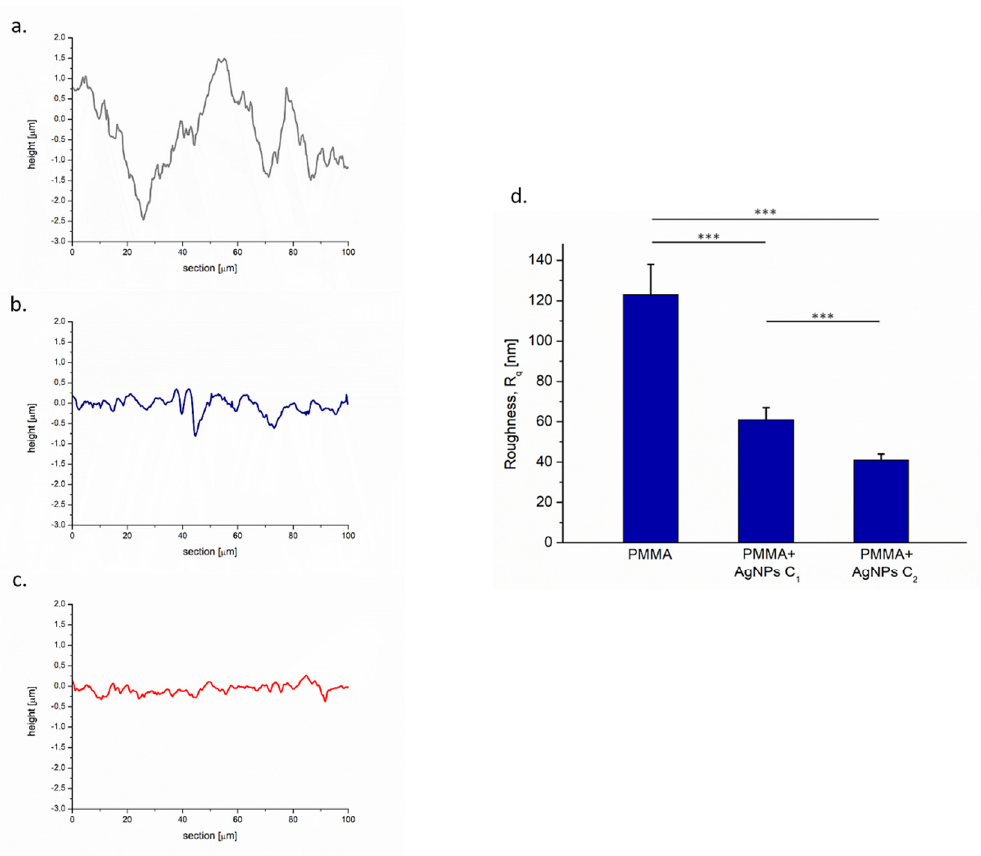
Figure 3. Representative cross-section profiles of PMMA surfaces without NPs added ( a ), PMMA + AgNPs C1 (3 wt%) ( b ) and PMMA + AgNPs C2 (3.5 wt%) ( c ). Roughness Rq values (nm) quantified on PMMA surfaces without NPs added ( a ), PMMA + AgNPs C1 (3 wt%) ( b ) and PMMA + AgNPs C2 (3.5 wt%) ( c ). ( d ) Data reported were calculated as average ± SD on three independent experiments, and the statistical significance respect to the control was represented (*** p -value < 0.005). Int. J. Mol. Sci. 2019 , 20 , x